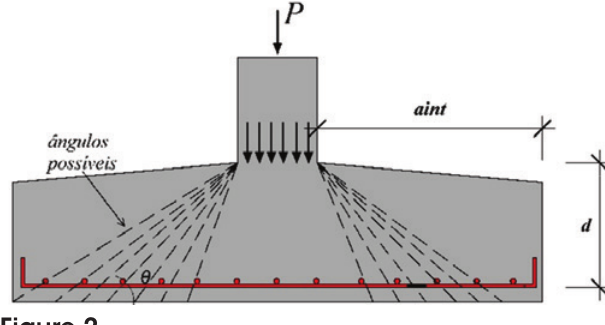
Punching shear failure in reinforced concrete footings without shear